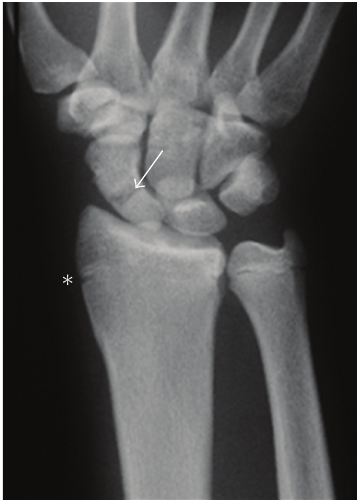
Figure 1: Plain coronal radiograph suggesting fracture at the waist of the scaphoid (arrow) and widening of the radial aspect of the distal radial epiphysis ( ∗ ).